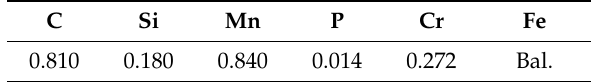
Table 1. Chemical composition of SWRS82B in this study